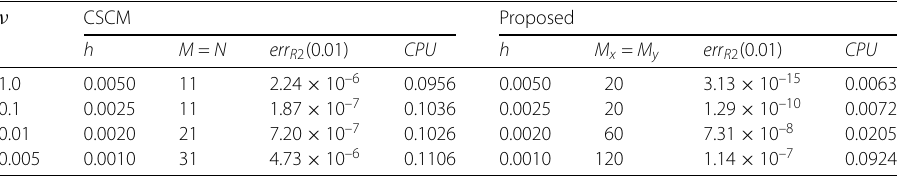
Table 5 Comparison of numerical results for u obtained from the proposed method and the CSCM for Example 3 ν